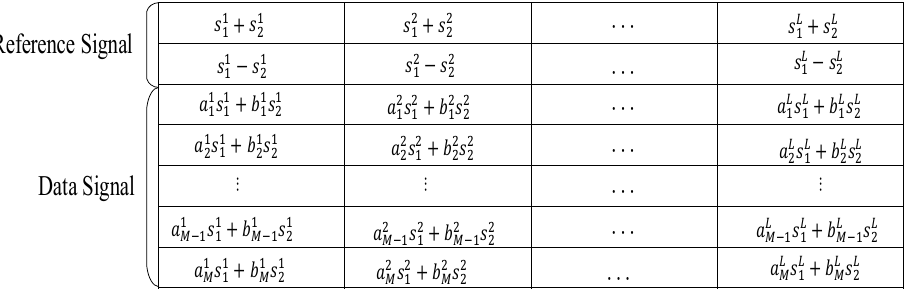
Figure 4. The signal structure of MC − ODBR − DCSK.